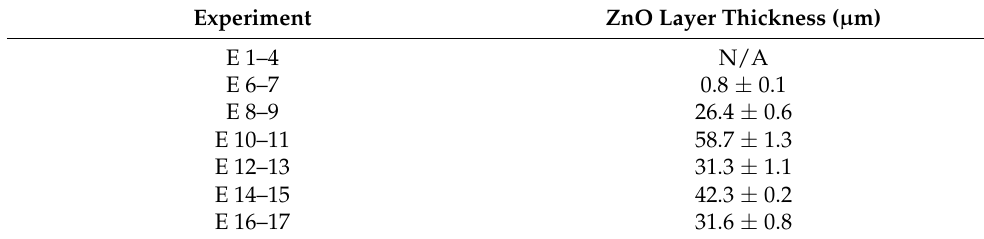
Table 5. Average thickness of ZnO layer obtained after the